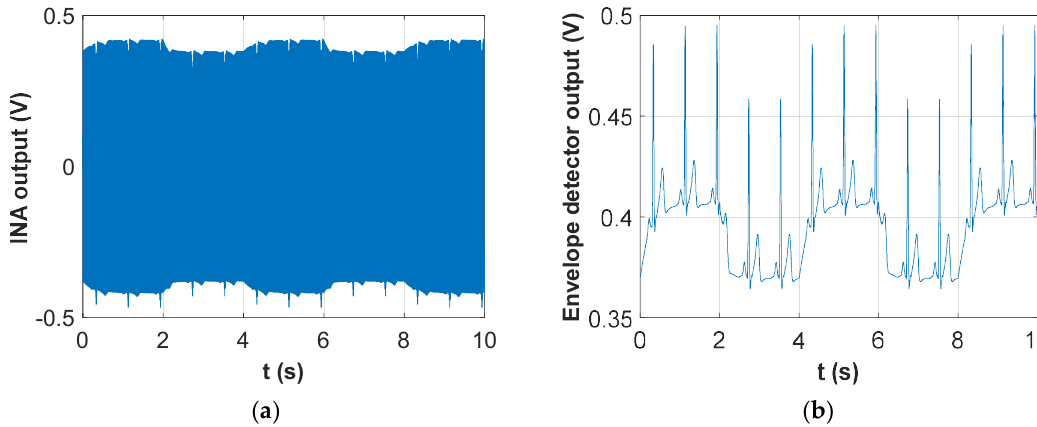
Figure 2. Synthetic example of a signal detected on the patient thorax through the scheme depicted in Figure 1: ( a ) Total voltage recorded across the thorax; ( b ) Output of the detection circuit after inverting rectification and envelope extraction.